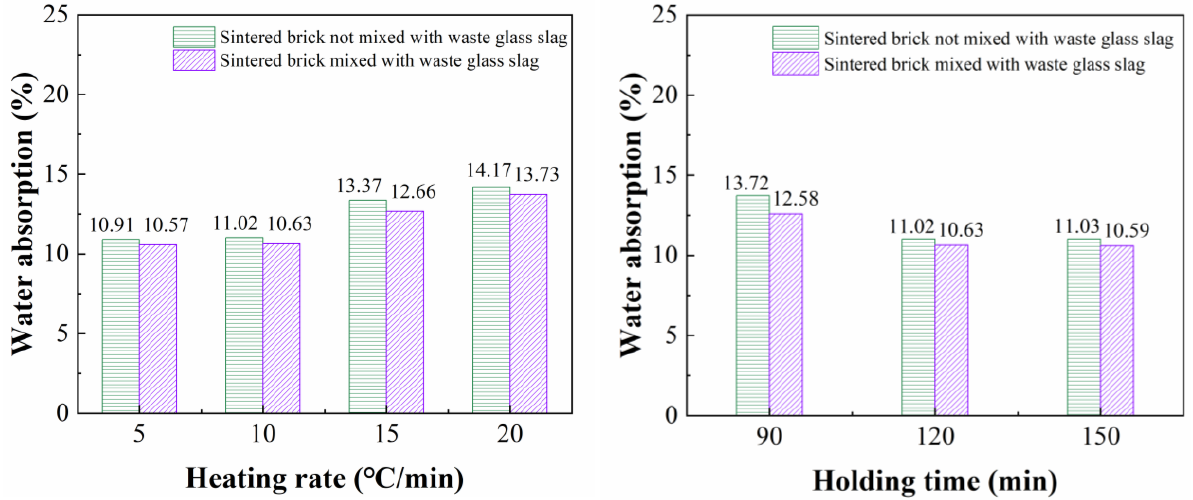
Figure 9. Effect of heating rate and holding time on weathering resistance of MGB sintered brick. (2) Influence law of sintering temperature on the weathering resistance of sintered